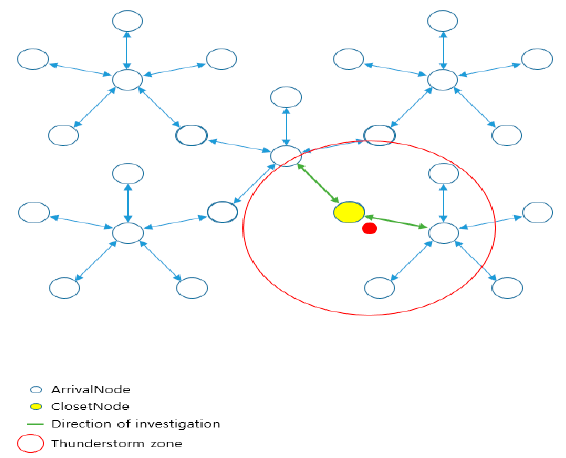
Figure 15. Node structure of points installed at regular intervals.